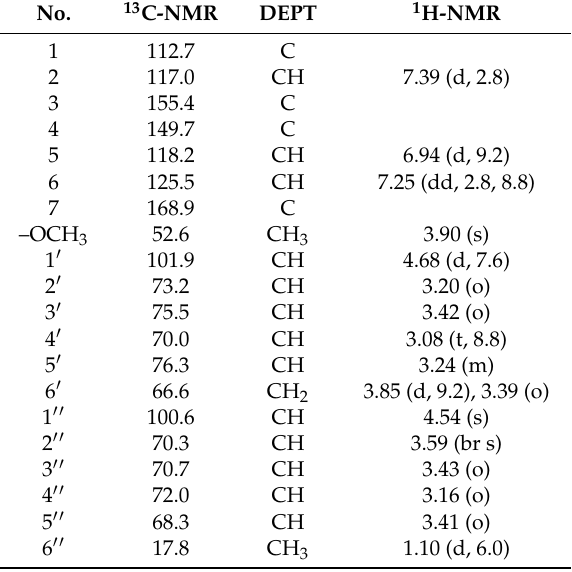
Table 2. 1 H- and 13 C-NMR data of the new compound 2 (in DMSO- d 6 , 400 MHz).